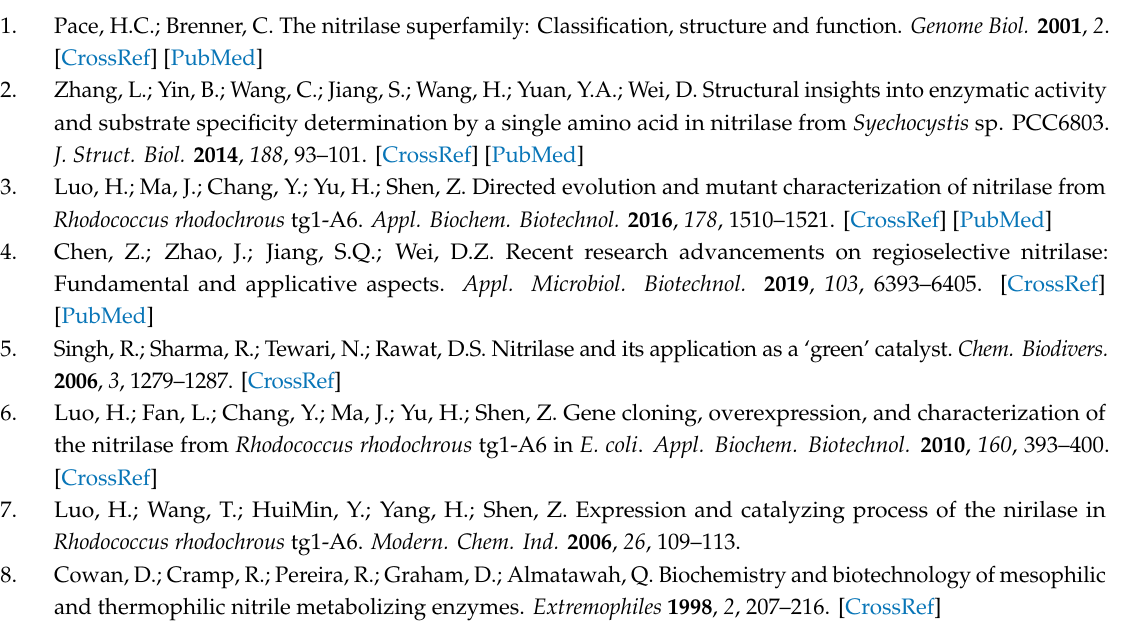
Supplementary Materials: The following are available online, Figure S1: Transcription level changes of R. ruber chaperones Rr GroES, Rr GroEL and Rr GroEL2; Figure S2: SDS-PAGE results of fusion chimeras; Figure S3: Nitrilase activity and the residual activity ratio of nitrilase in the E. coli BL21(DE3) recombinant strains (pET28a- Rr Nit), (pET28a- Rr Nit-FxL1- Rr Hsp16) and (pET28a- Rr Nit-FxL1-rTHS); Figure S4: Substitution of NHase with nitrilase using CRISPR / Cas9 tools in the genome of R. ruber TH3; Figure S5: DNA electrophoresis results to verify the successful deletion of NHase and insertion of nitrilase; Figure S6: CRISPR / Cas9 systems for R. ruber and the experimental process for constructing the engineered strains R. ruber TH3 dNHase:: Rr Nit, TH3 Table S1:Plasmids and strains used in this study; Table S2: PCR primers used in this study. Author Contributions: Conceptualization, formal analysis, writing—original draft preparation, writing—review and editing, C.X.; experimental validation and methodology, L.T.; CRISPR / Cas9 methodology, Y.L. and S.J.; resources, supervision, projectadministration, fundingacquisition, H.Y.; nitrilasegenesupervision,